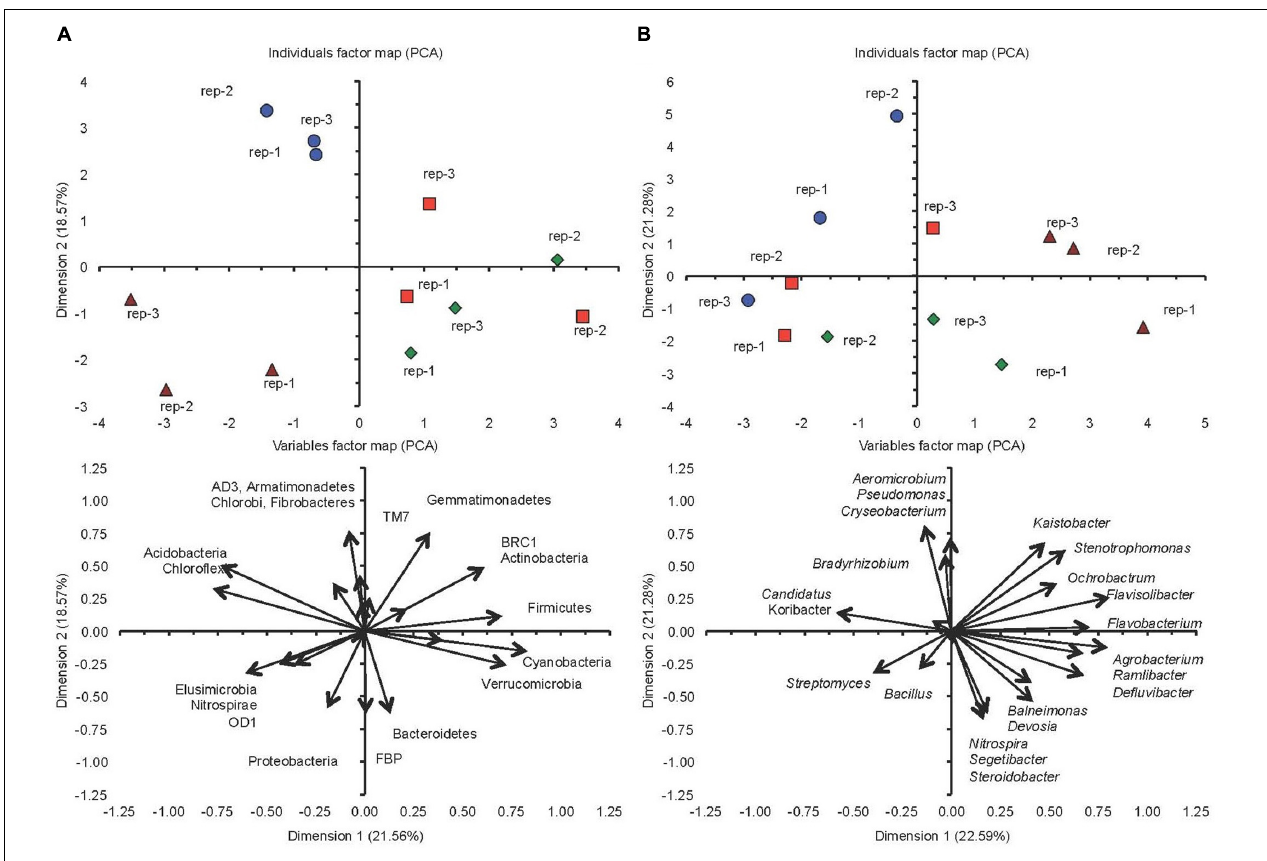
FIGURE 3 | (A) Principal component analysis with the different bacterial phyla and (B) the 20 most abundant genera in soil cultivated conventionally incubated at 5% of field capacity ( ) or field capacity ( ) or milpa soil incubated at 5% of field capacity ( ) or field capacity ( ) incubated aerobically for 45